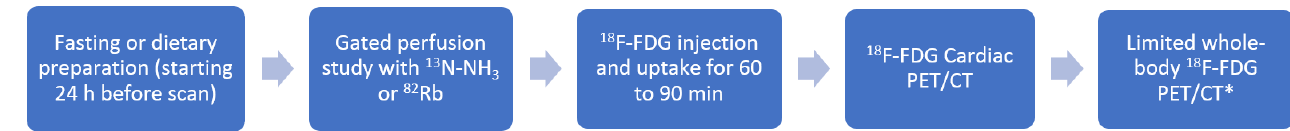
Figure 1. Outline of the typical PET protocol for evaluation of CS. * If there is clinical suspicion of extracardiac CS, include at least the chest, liver, and spleen.